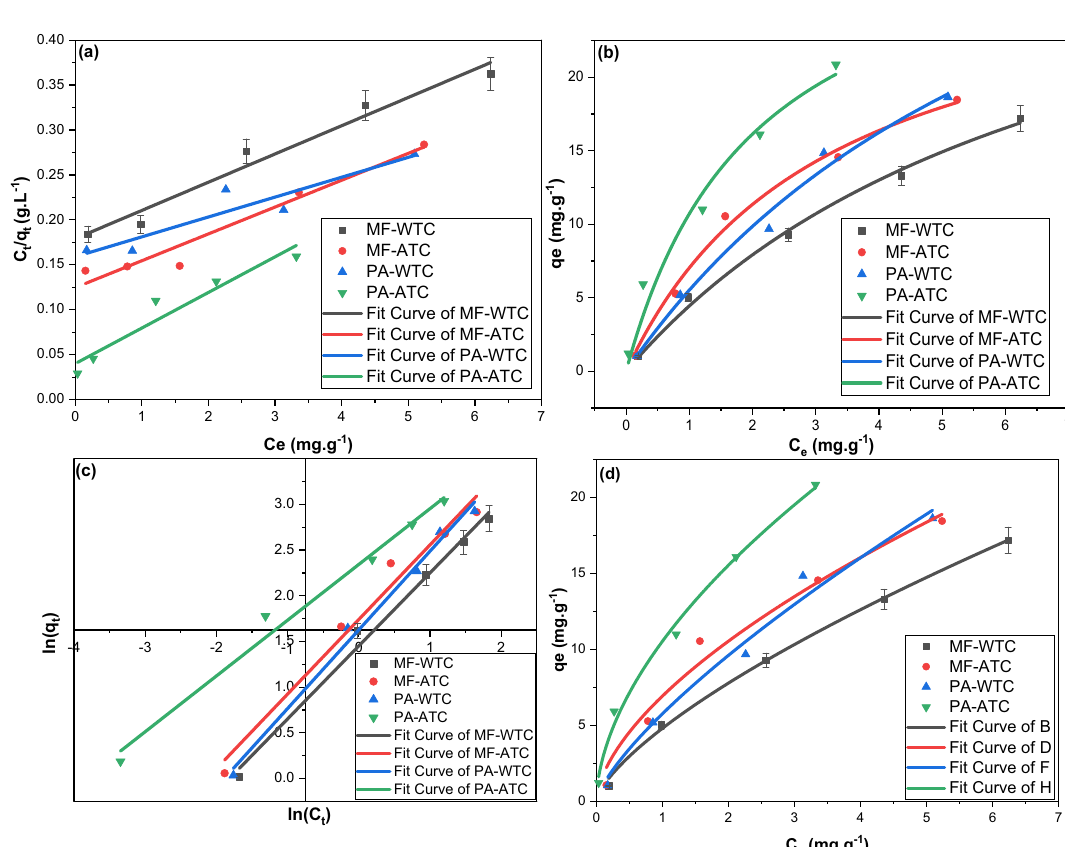
Figure 5. ( a ) LLM, ( b ) NLLM, ( c ) LFM and ( d ) NLFM for the adsorption of PA and MF on WTC and